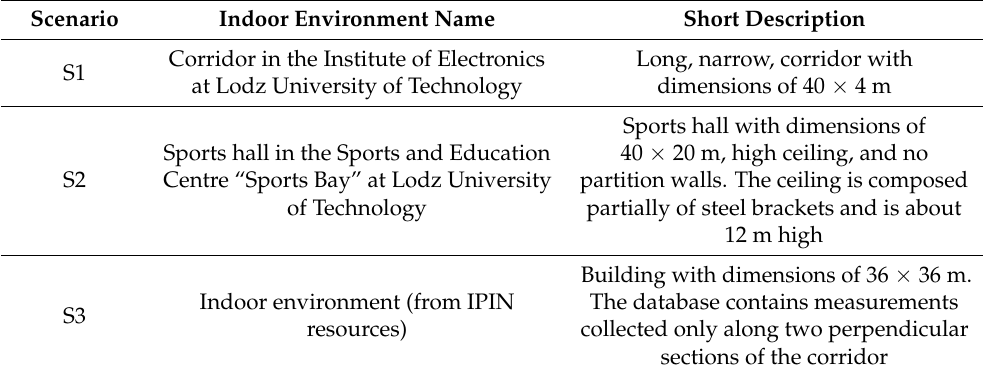
Table 2. Test scenarios to verify localization accuracy in buildings using simulated RSSI